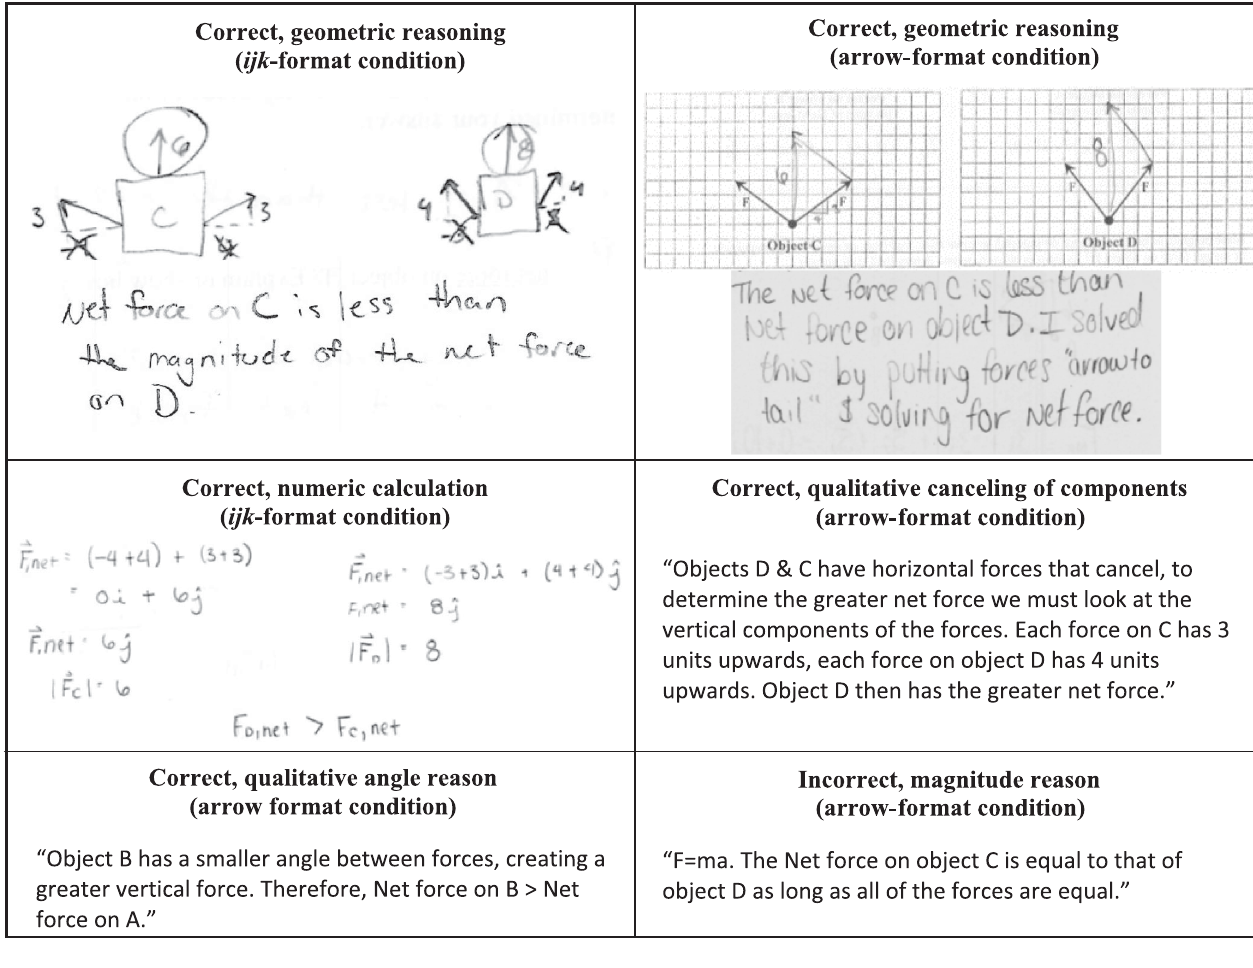
FIG. 12. Assortment of example student solutions to simple two-dimensional physics context questions (Fig. 11) in both arrow and ijk formats. Response rates are in Table